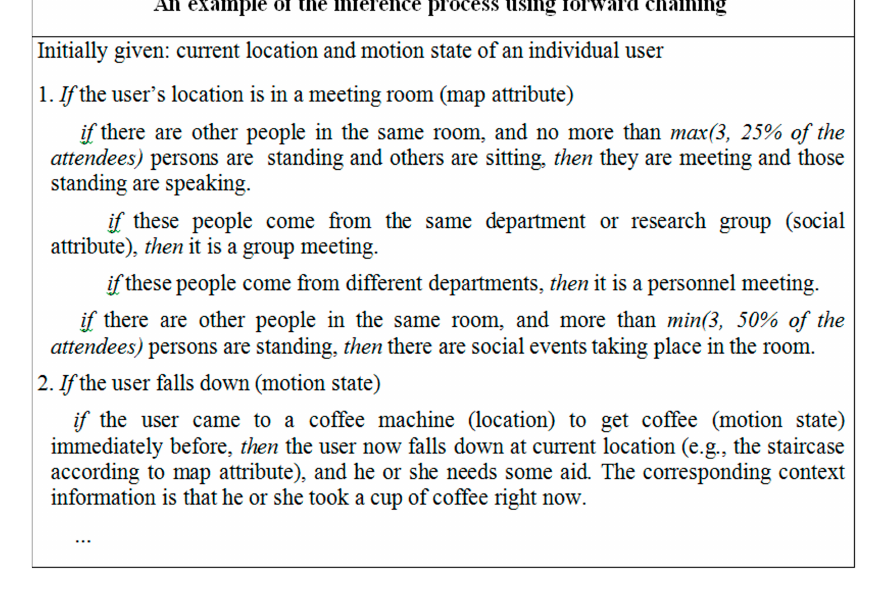
Figure 8. Process of the forward chaining method for geo-context